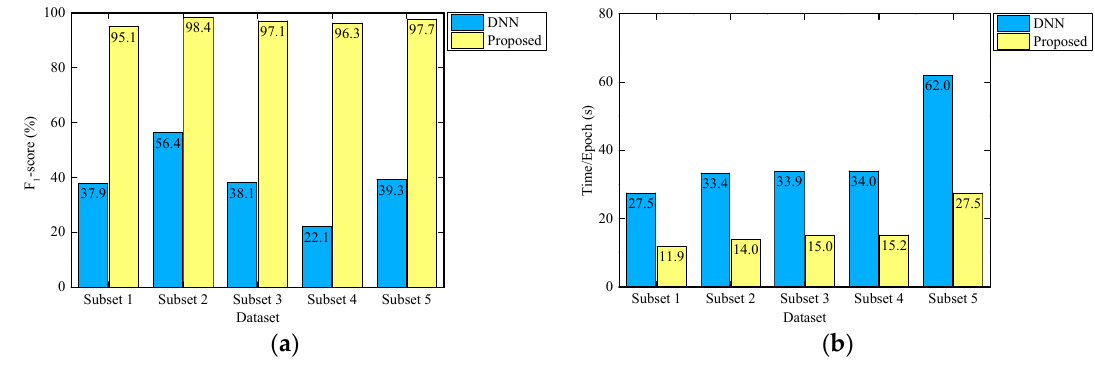
Figure 12. Detection performance comparison of the proposed model and the deep neural network (DNN) model. ( a ) F 1 -score on the testing set; ( b ) Time/Epoch.